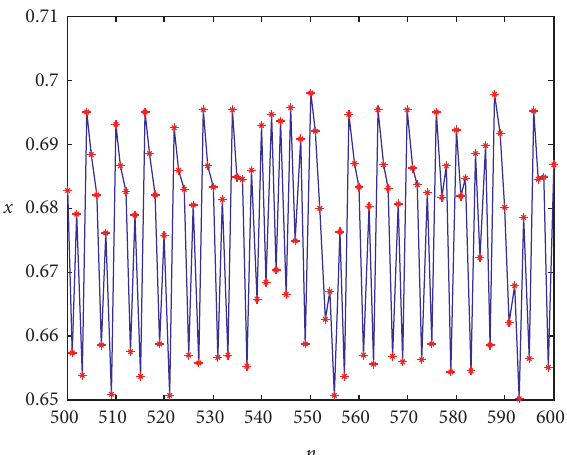
Figure 3: x – n sequence diagram which denotes that the system is chaotic when α �